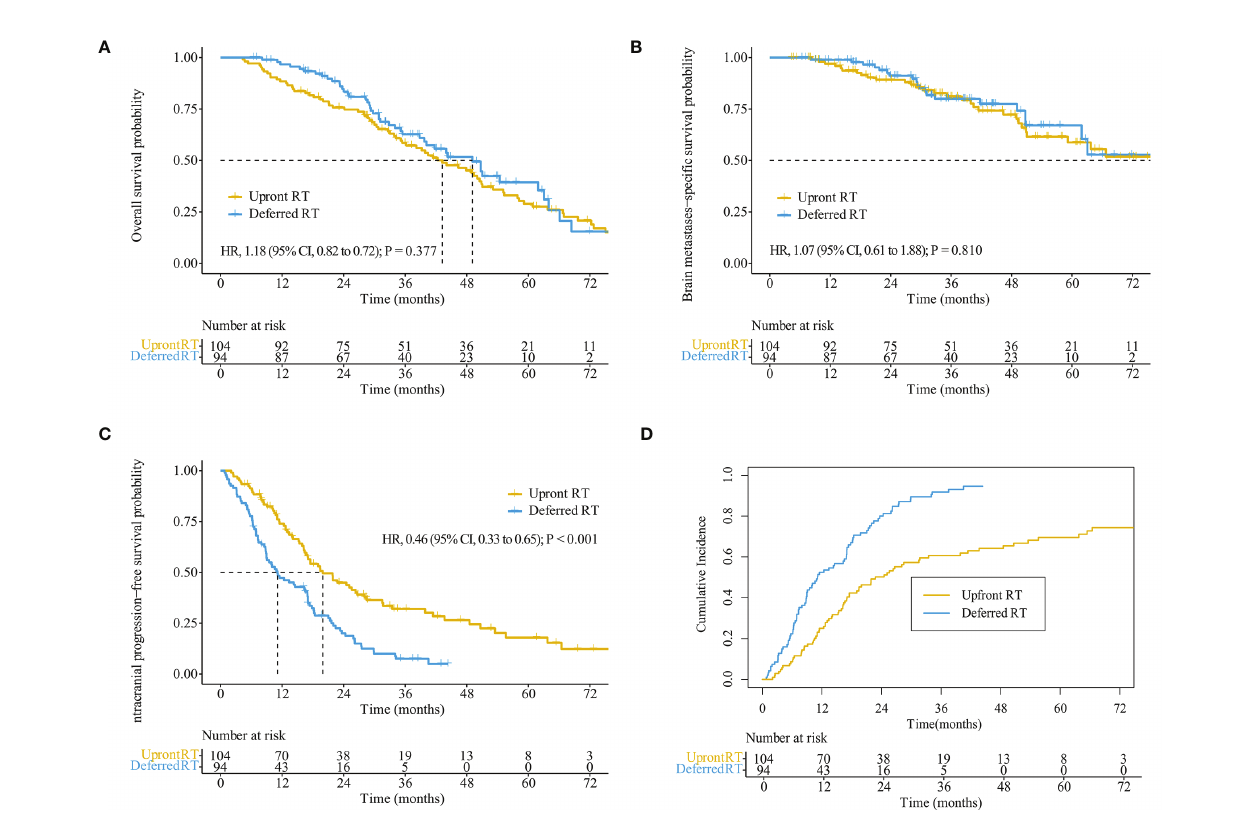
FIGURE 2 | Kaplan – Meier analysis comparing survival strati fi ed by treatment regimens in the entire cohort. Overall survival (A) , brain metastases-speci fi c survival (B) , intracranial progression-free survival (C) , and cumulative incidence of intracranial progression using competing risks regression analysis (D) .